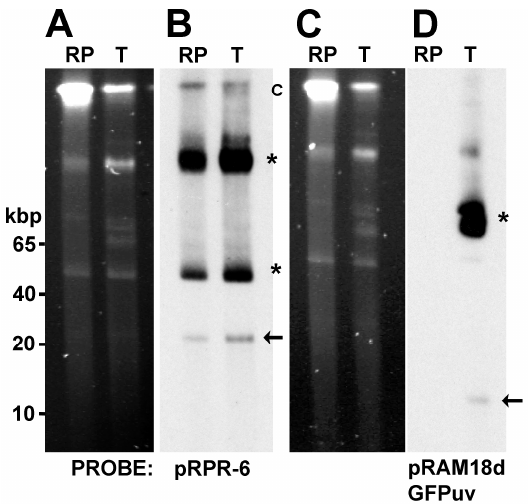
Figure 4. Identification of plasmids pRPR and pRAM18d in untransformed R. peacockii (RP) and transformant (T) by PFGE and Southern blot (SB) analysis. Panels A and C. PFGE gels showing prominent chromosomal band and several plasmid bands; Panels B and D. Southern Blots of gels shown in panels A and C; Panel B. Southern Blot probed with digoxygenin labeled pRPR-6 (probe specific RP_p06 gene in pRPR). Arrow points to linear monomer of native 26 kb plasmid of R. peacockii ; Panel D. Southern blot probed with digoxygenin labeled GFPuv probe. Note probe binding in lane T only and absence of reactivity in RP lane. Arrows mark putative linear monomer of each plasmid and asterisks indicate their conformational isomers; Panel B. Note pRPR-6 probe reactivity in both RP and T. Linear DNA marker positions are to the left of panel